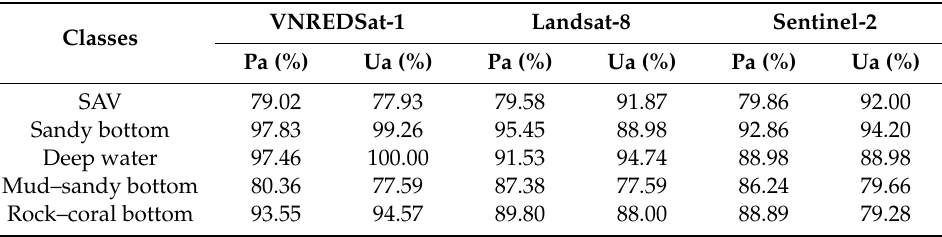
Table 8. The Producer’s accuracy and User’s accuracy in estimating the five substrate types (classes) from the three